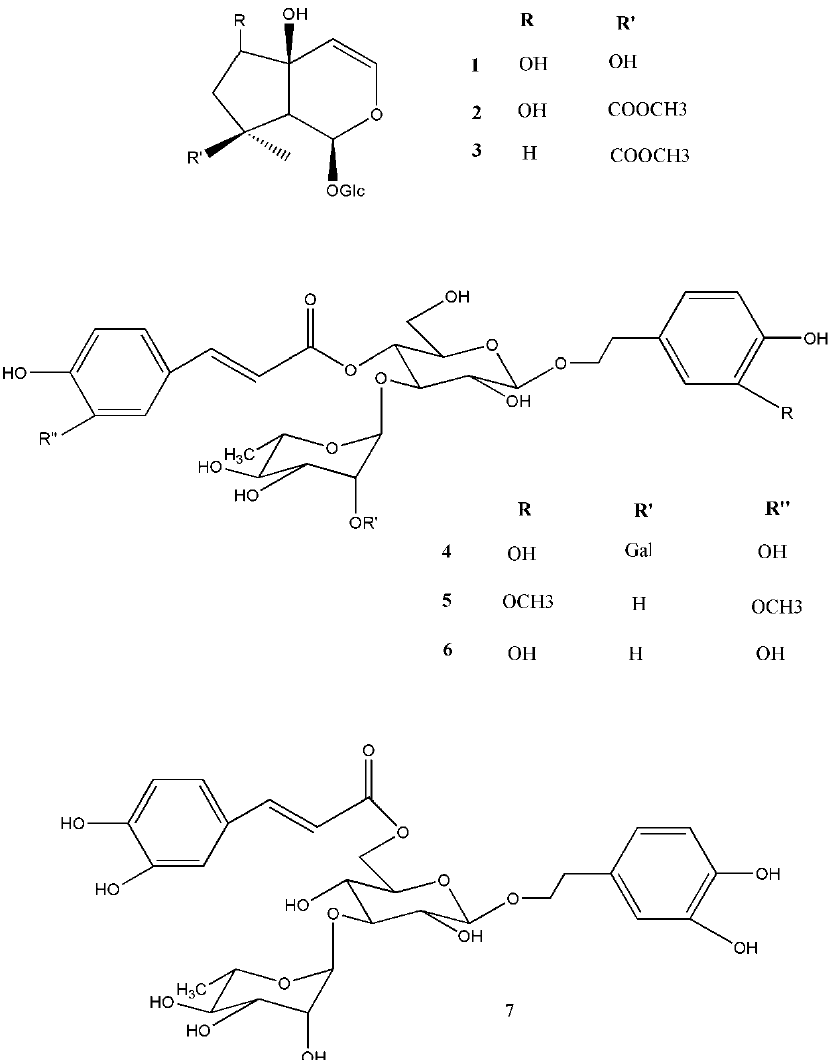
Figure 1. Major chemical constituents of AJ extract: iridoid glycosides (harpagide ( 1 ), 8-O-acetylharpagide ( 2 ), and reptoside ( 3 )) and phenylpropanoid glycosides (teupolioside ( 4 ), martinoside ( 5 ), verbascoside ( 6 ), and isoverbascoside ( 7